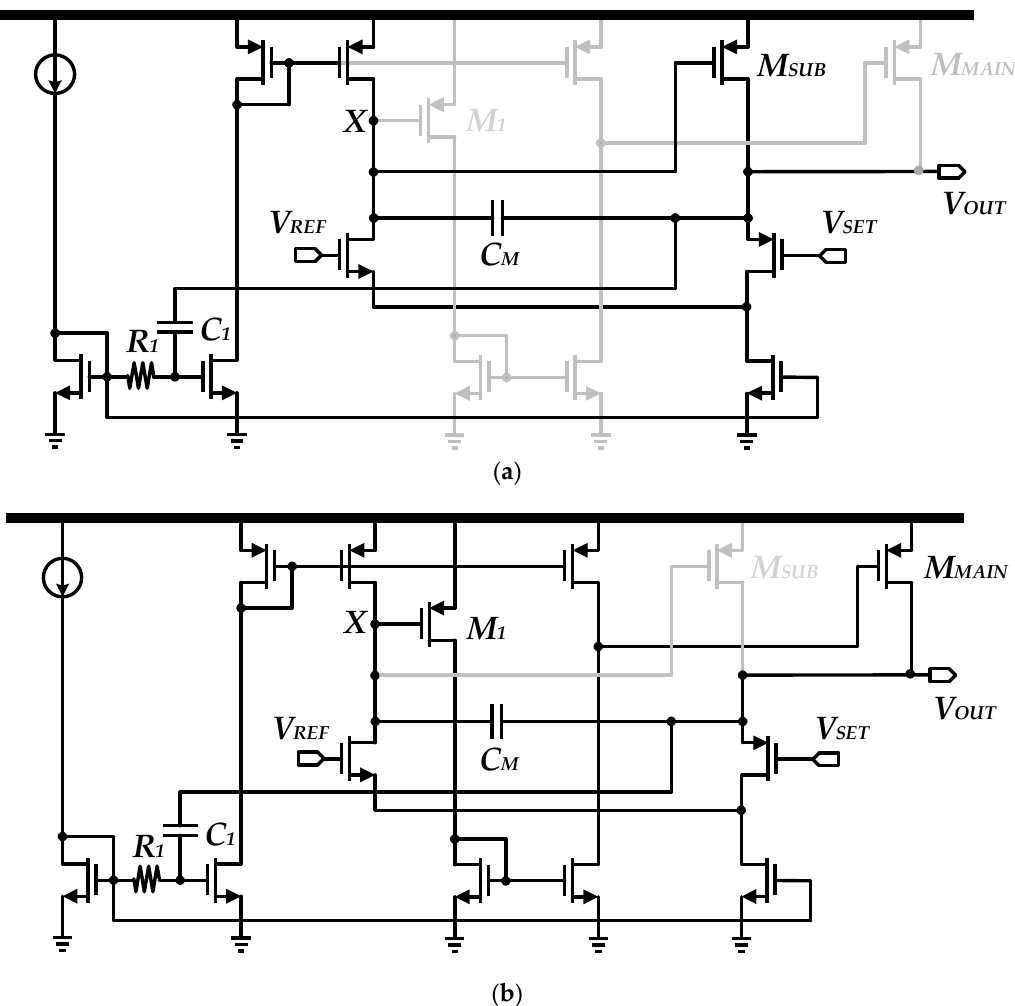
Figure 8. Operation principle of the proposed LDO. ( a ) with a light load current; ( b ) with a heavy load current.